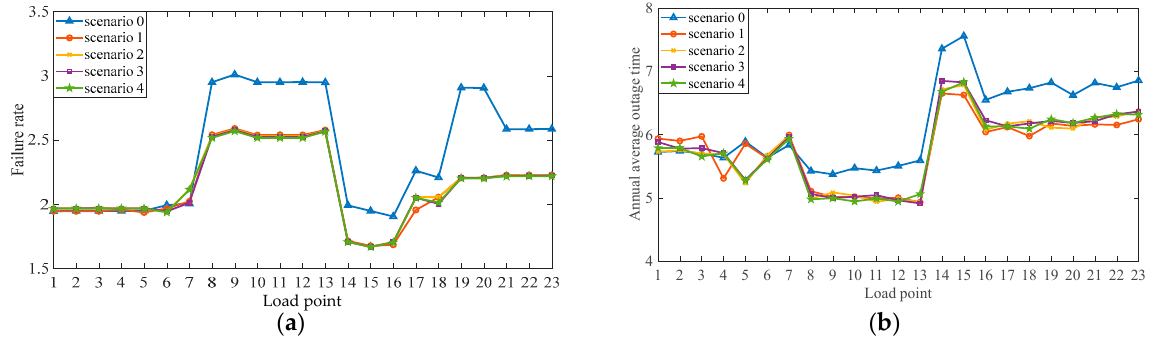
Figure 7. Load point reliability indexes: ( a ) Average annual outages number; ( b ) Average annual outage time.